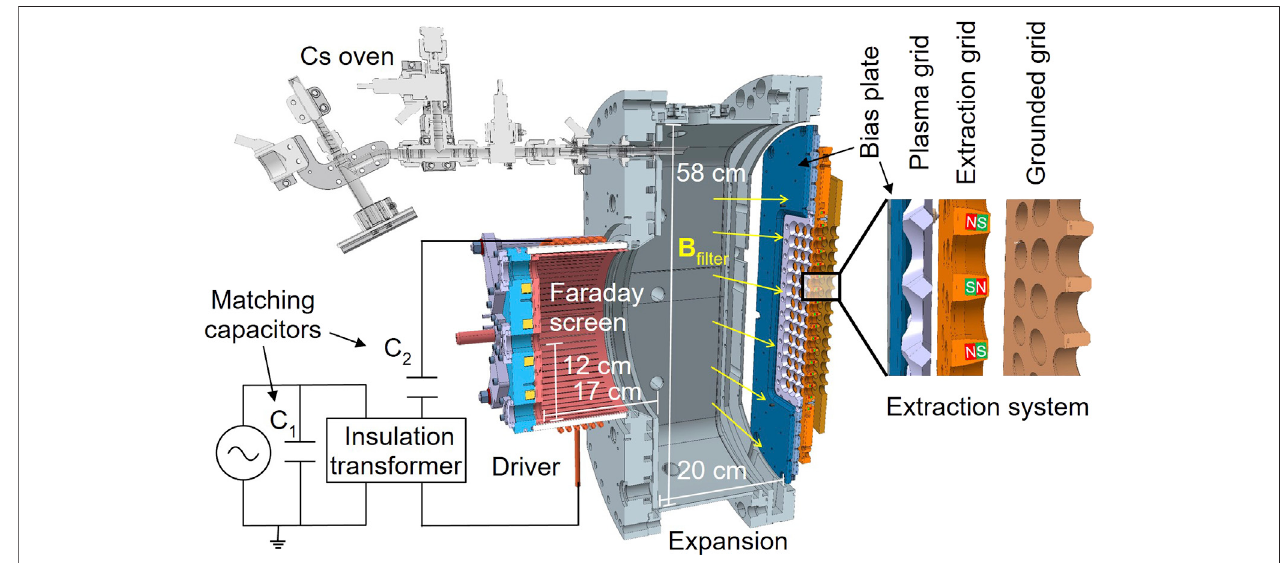
FIGURE 1 | Schematic view of the ion source setup and the RF circuit of the prototype source at the BATMAN Upgrade testbed.